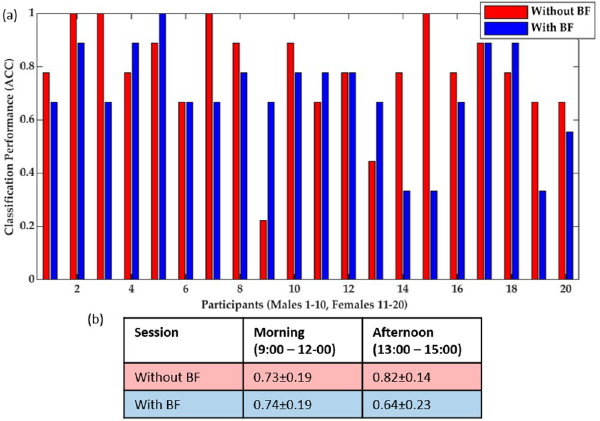
different time of the day (Morning and